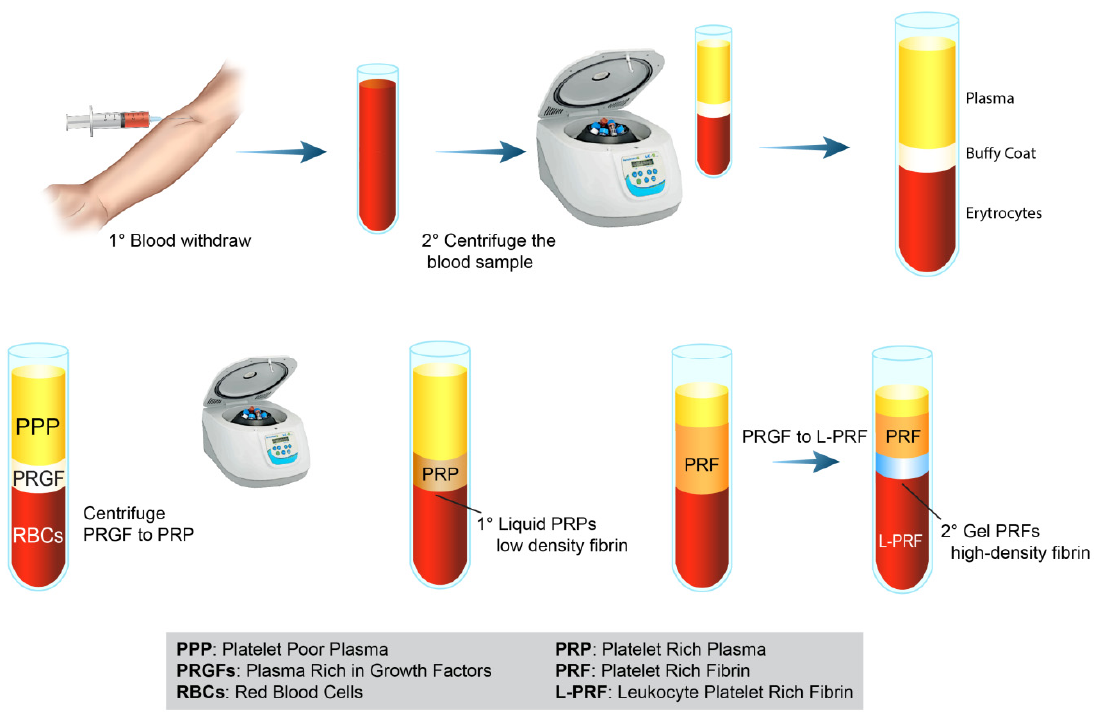
Figure 3. PLT concentrates preparation, types / classes, and illustration / presentation of PLT derivatives. Schematic drawing of the classical preparation protocols of PRP and PRF.